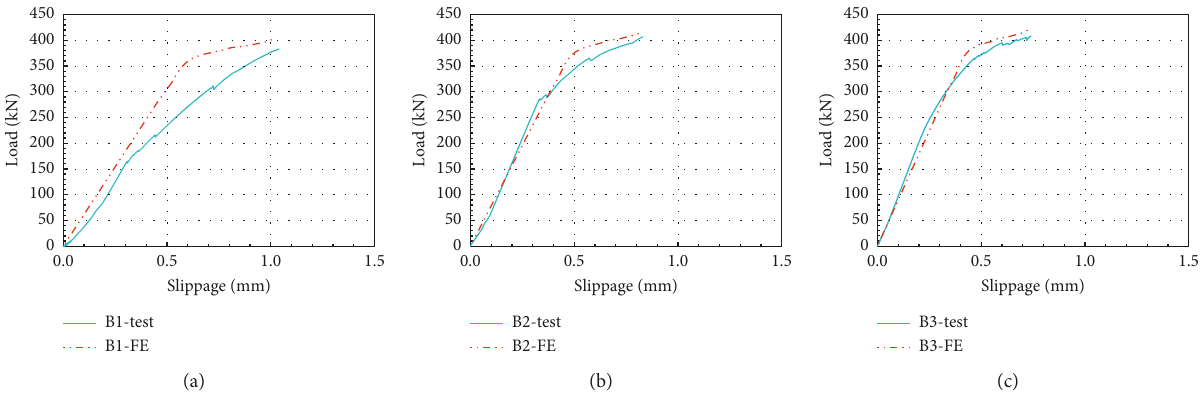
Figure 15: Comparison of the load-slippage curves from the test and FE analysis.